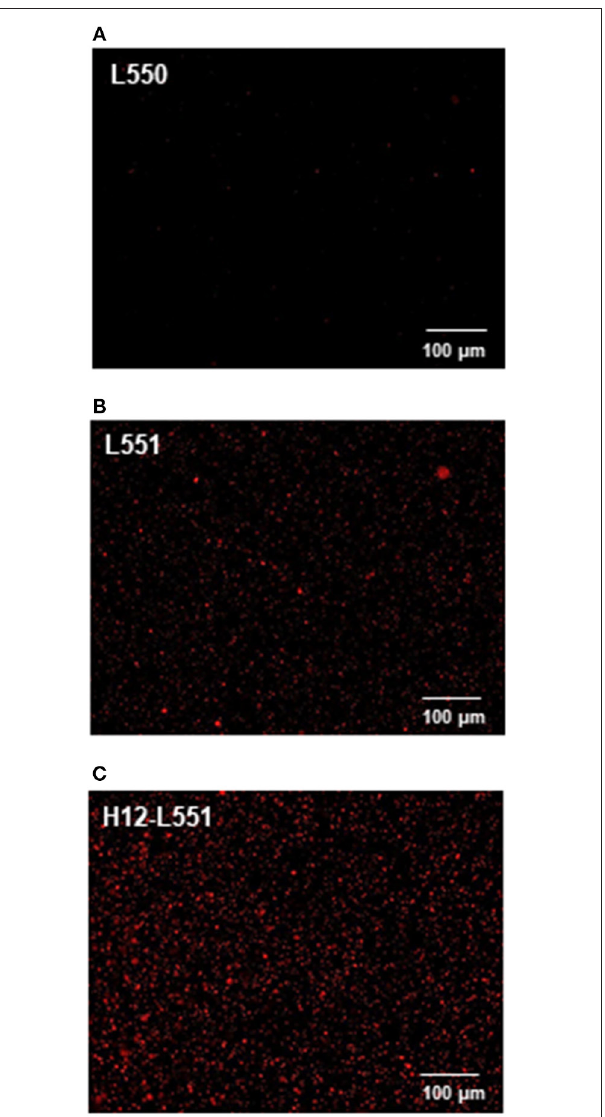
FIGURE 4 | Microscopic images representing the fluorescently labeled unmodified liposomes (A) L550, (B) L551 and H12-modified liposomes (C) H12-L551 in platelet